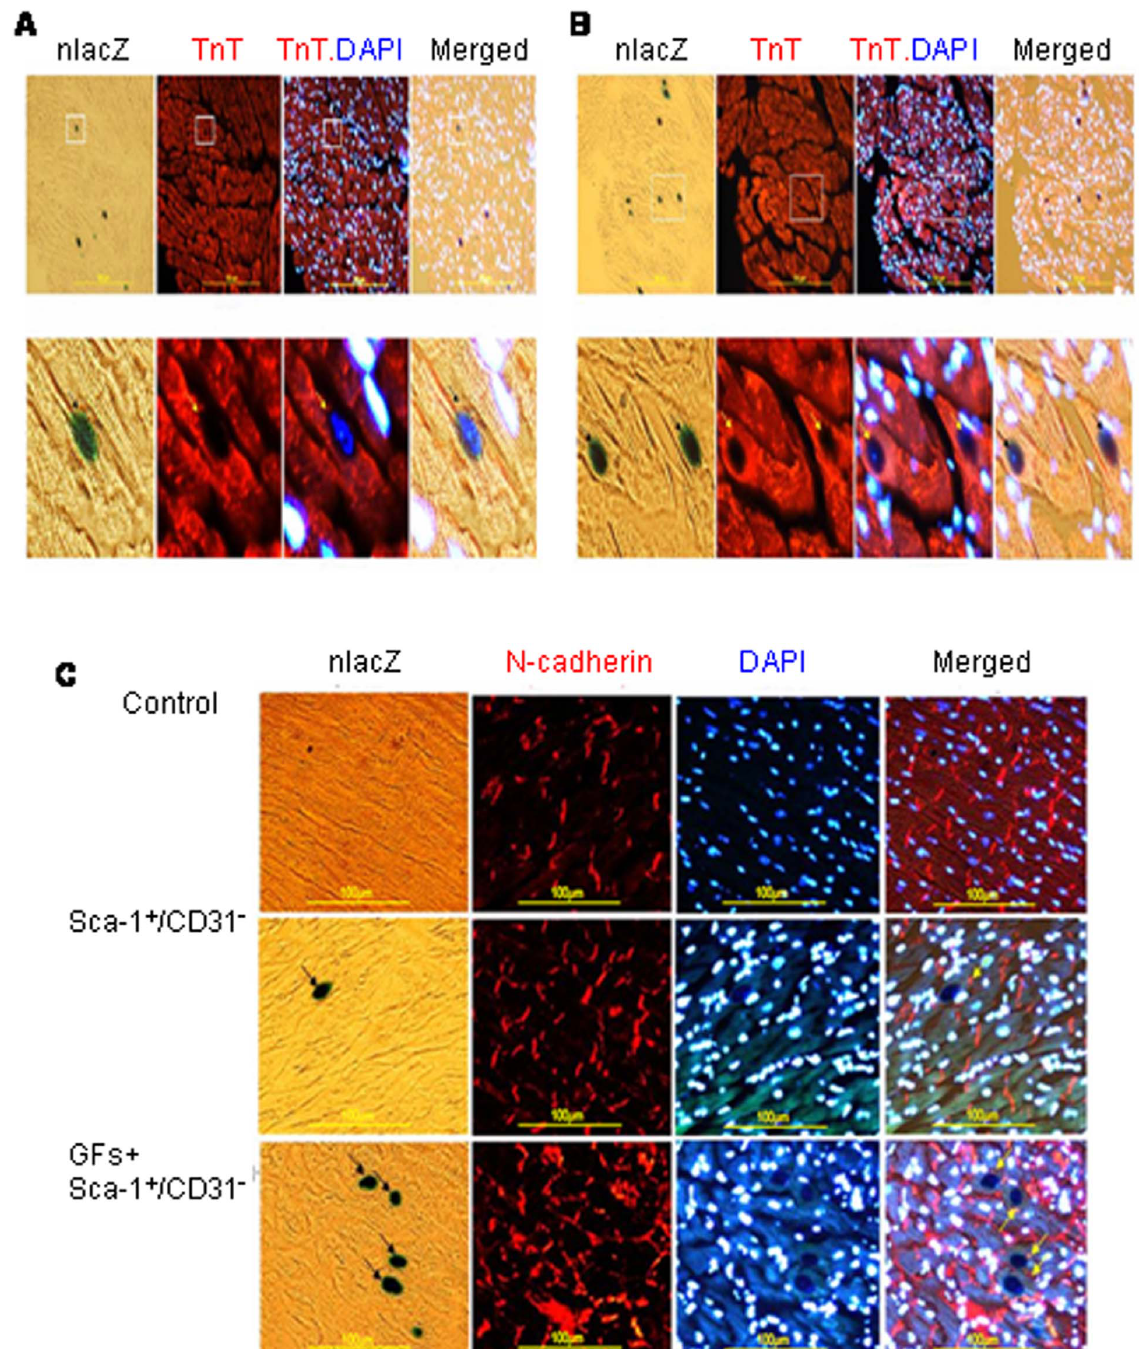
Figure 3. IGF + HGF supplementation increases the number (but not the per cent) of engrafted donor cells expressing cardiogenic markers. ( A ) . Representative immunofluorescence staining of engrafted Sca-1 + /CD31 – cells expressing the cardiac-specific marker, troponin T, 2 weeks after transplantation. Upper panel: low magnification; Lower panel: high magnification; Sequential photomicrographs in each row show nuclear X-gal staining (dark blue), troponin T (red), Troponin and DAPI nuclear staining (light blue), and merged images. Arrow points to triple- positive cells which also showed striations characteristic of cardiomyocytes. ( B ) . IGF + HGF supplementation enhanced the number of engrafted Sca- 1 + /CD31 – cells expressing cardiomyocyte marker, Troponin T. Upper panel: low magnification; Low panel: high magnification; Subsequent photomicrographs in each row show nuclear X-gal staining (dark blue), troponin T (red), Troponin and DAPI nuclear staining (light blue), and merged images. Arrows point to triple-positive cells. ( C ) . IGF + HGF supplementation enhanced the number of the transplanted Sca-1 + /CD31 – cells expressing gap junction protein, N-cadherin (low magnification). Upper panel: tissue from normal heart; Middle panel: tissue from Sca-1 + /CD31 2 cell transplantation heart; Low panel: Tissue from IGF + HGF supplementation heart; Subsequent photomicrographs in each row show nuclear X-gal staining (dark blue), N-cadherin (red), N-cadherin and DAPI nuclear staining (light blue), and merged images. Arrows point to triple-positive cells. DAPI, 4,6-diamidino-2-phenylindol dihydrochloride; X-gal, 5-bromo-4-chloro-3-indolyl- b -D-galactoside.